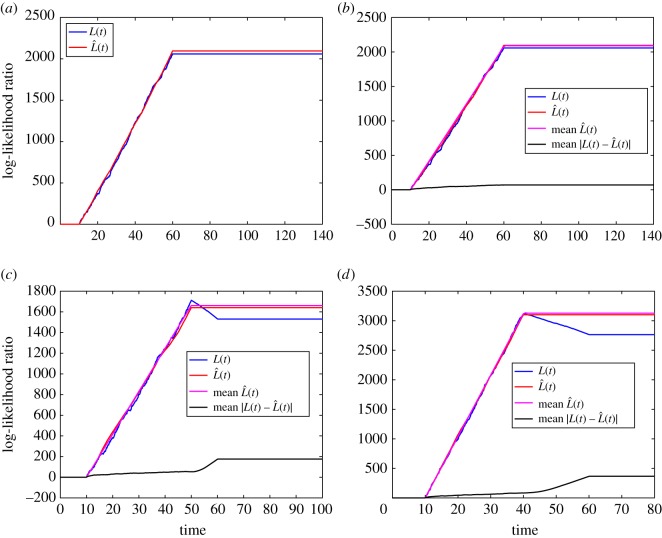
Numerical results for intermediate approximation.